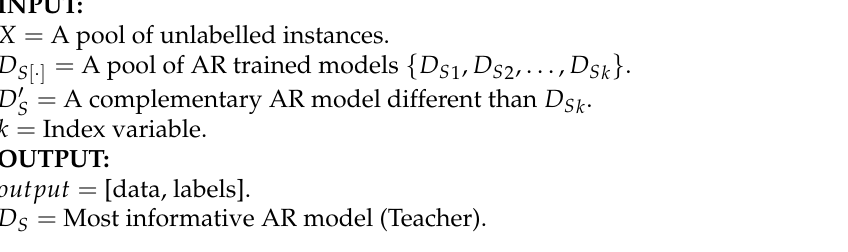
Algorithm 1 Selection of the teacher models and training of the untrained learner model.